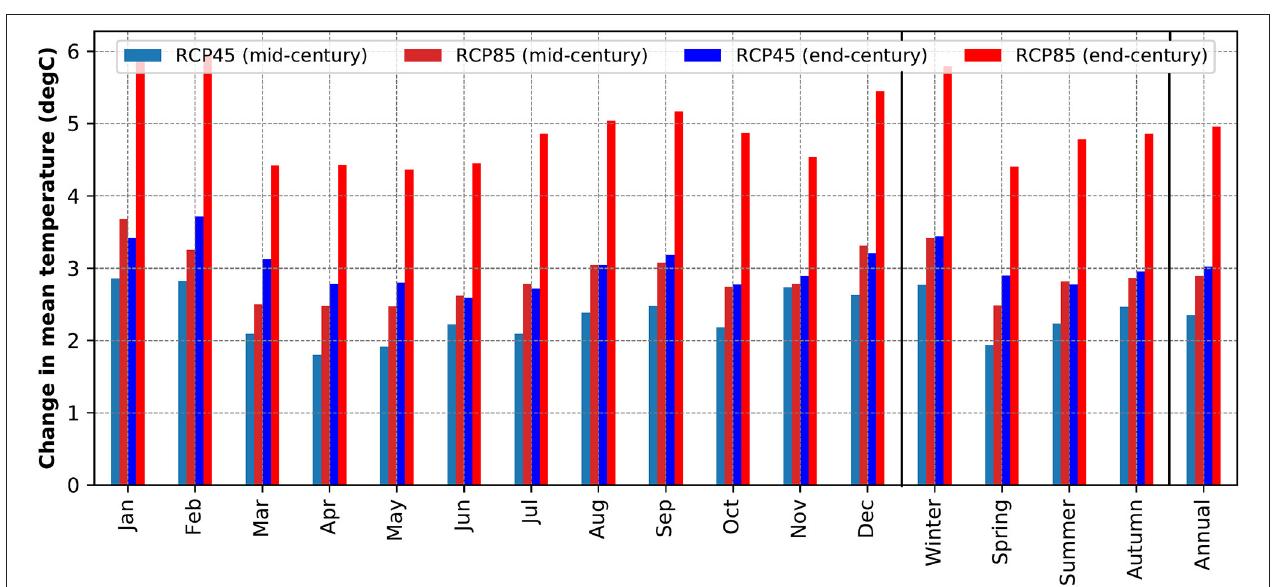
FIGURE 9 | Absolute change in monthly, seasonal, and annual mean temperature of GL basin with respect to baseline mean temperature for RCP 4.5 and RCP 8.5 emission scenarios in both mid- and end-century periods.